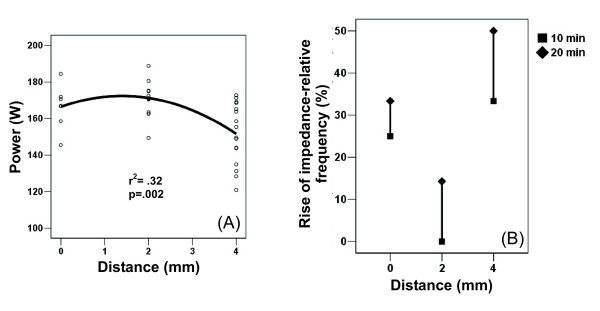
Effect of perfusion distance on energy deposition into the tissue. Three perfusion distances were tested: 0 mm (n = 7), 2 mm (n = 12) and 4 mm (n = 16). Scatter plot shows non-linear (quadratic) relationship between distance and deposited power (A). Goodness of fit of the model is assessed by r2. Note the improved effect at perfusion distance of 2 mm on deposition of power. Additionally, a drop-line chart (B) summarizes the observed relative frequency of an uncontrolled rise of impedance within two RFA durations (10 and 20 min) for the three values of perfusion distance. Note the lower rate of impedance rise during the procedure at a distance of 2 mm. In all cases, longer durations (20 minutes) were linked to a higher rate of impedance rise.